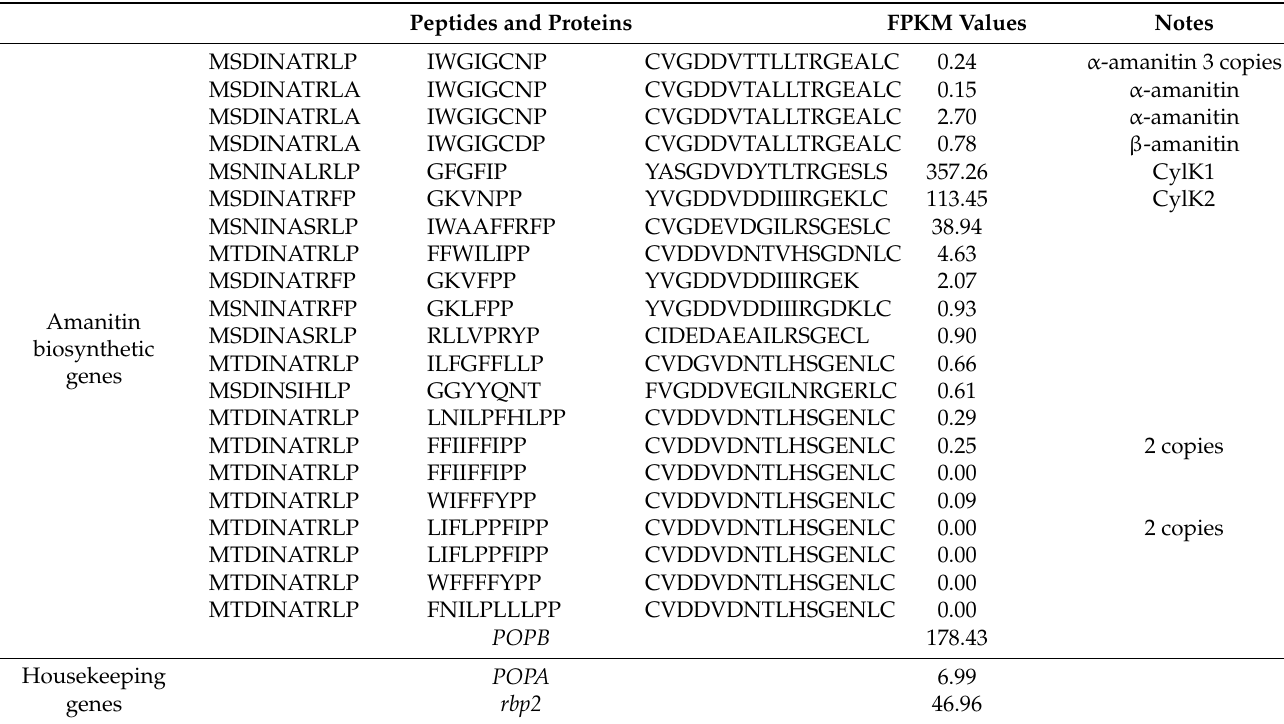
Table 1. Transcription of amanitin biosynthetic and housekeeping genes of Amanita molliuscula. Peptides and Proteins FPKM